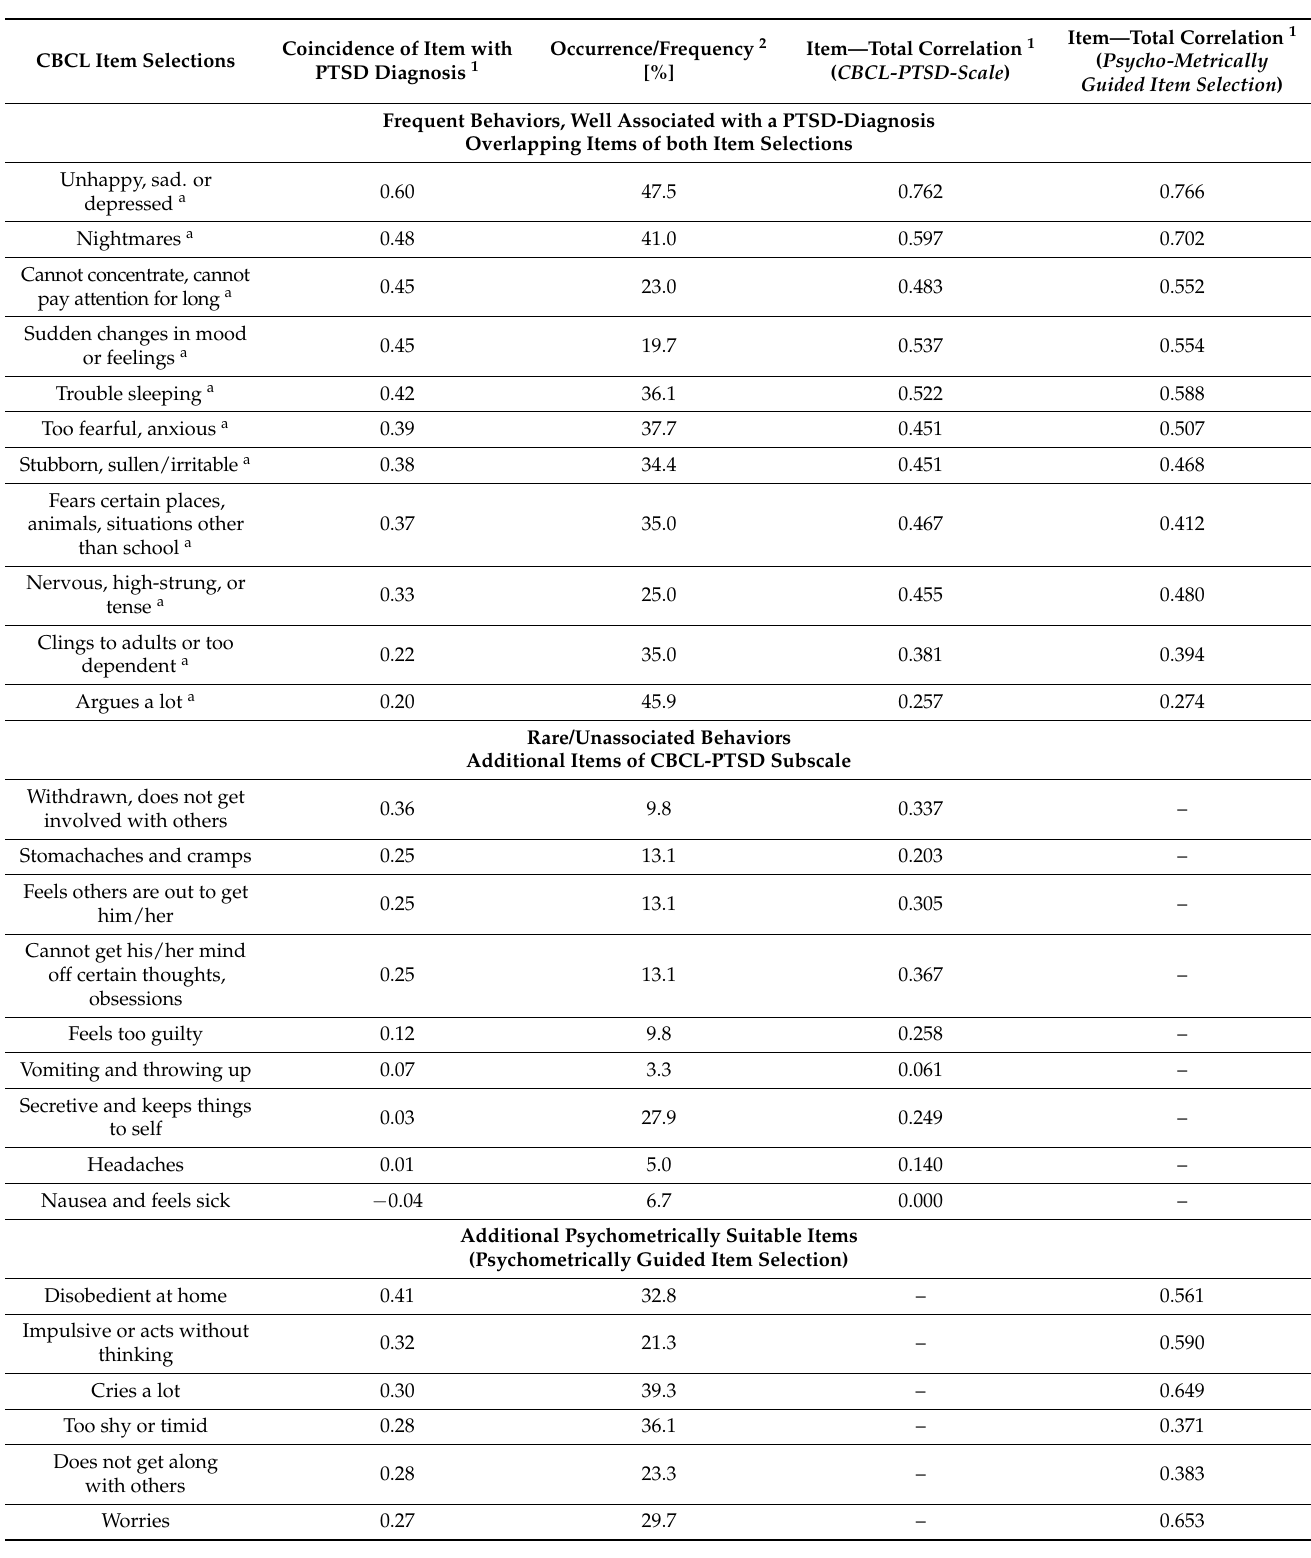
Table 3. Selections of CBCL items used for analyses: CBCL-PTSD subscale as developed by Wolfe et al. [16] and psychomet- rically guided item selection. Eleven items (marked with a ) are frequent behaviors, well associated with a PTSD-diagnosis and identical in both tested item